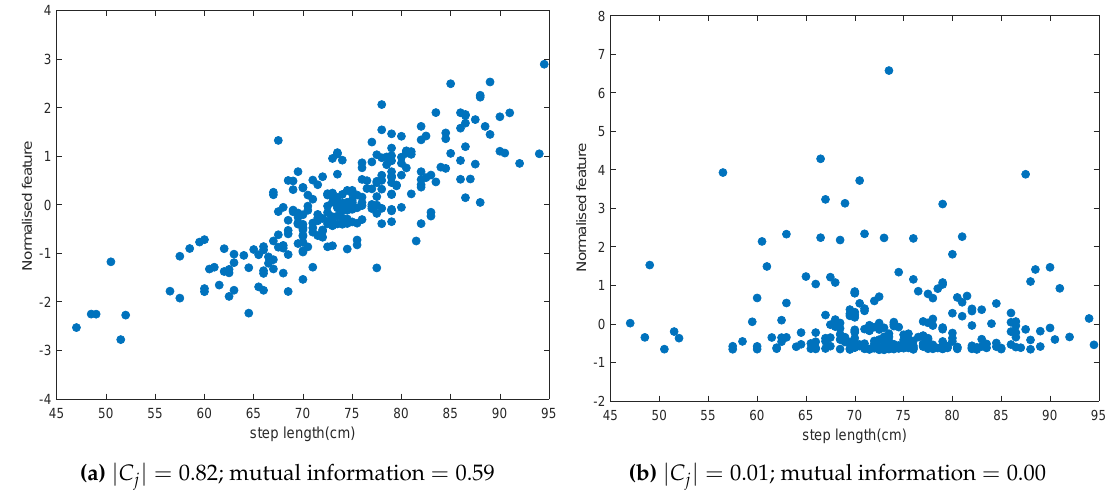
Figure 6. Feature values in function of the step length for ( a ) a good feature ( b ) a bad